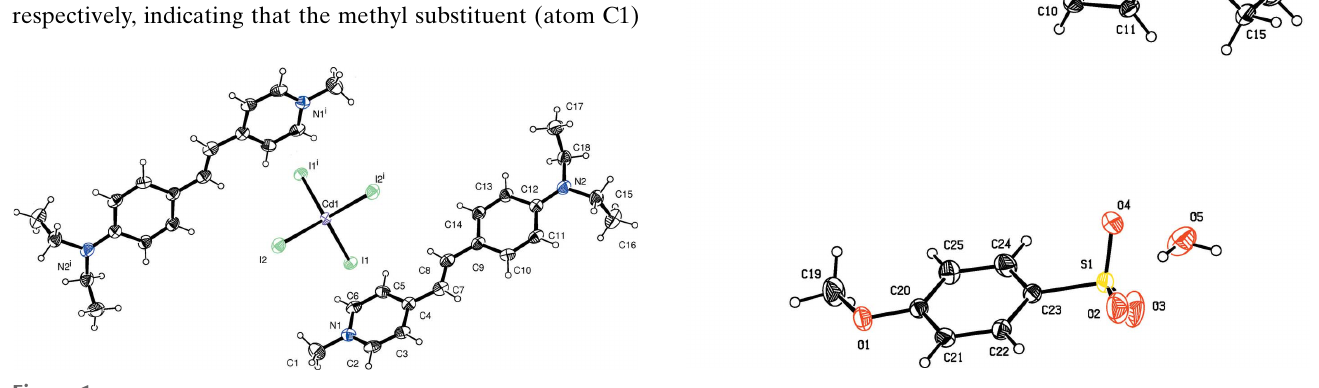
Figure 2 The molecular structure of salt (II), with atom labelling. Displacement ellipsoids are drawn at the 30% probability level.